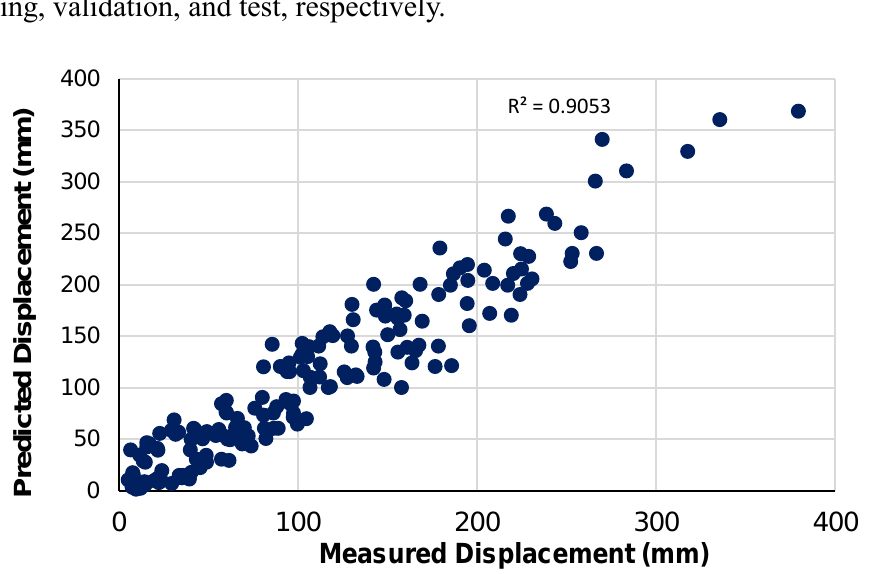
Fig. 2. Correlation between the output and target values for training data.